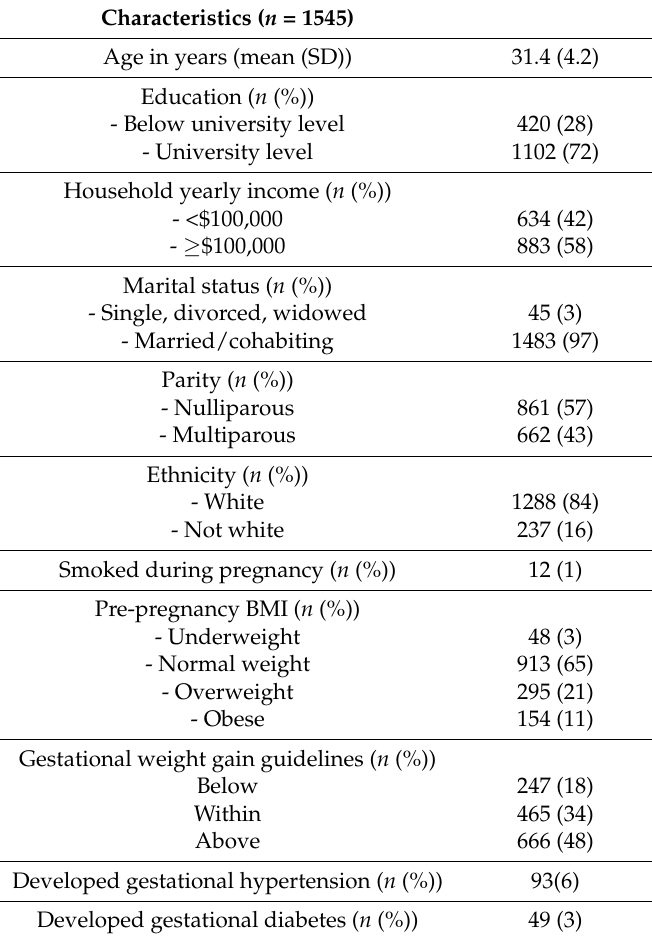
Table 1. Participant characteristics. BMI: body mass